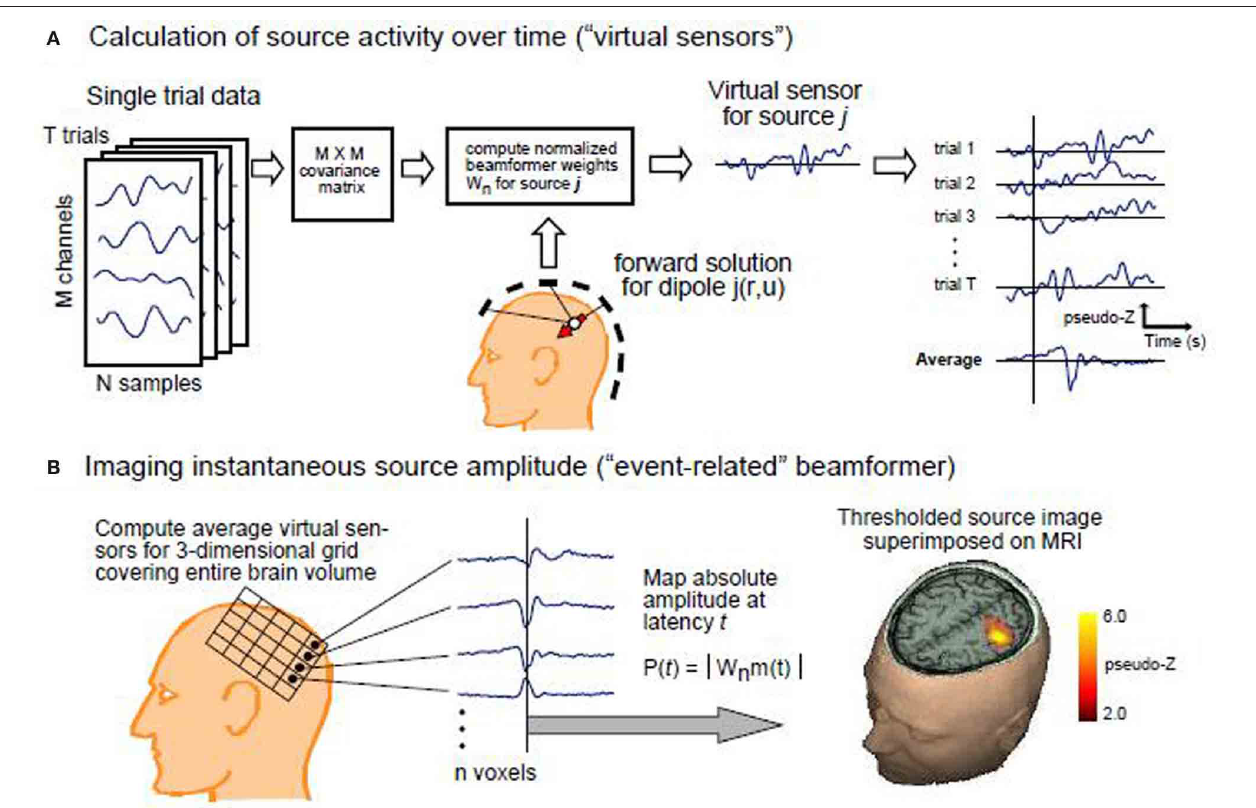
FIGURE 2 | The diagram of the event related beamformer (Cheyne et al., 2007). (A) Calculation of source activity over time: the data consists of T trials each with M channels and N time samples. The covariance matrix of the data are given to the beamformer as well as the forward